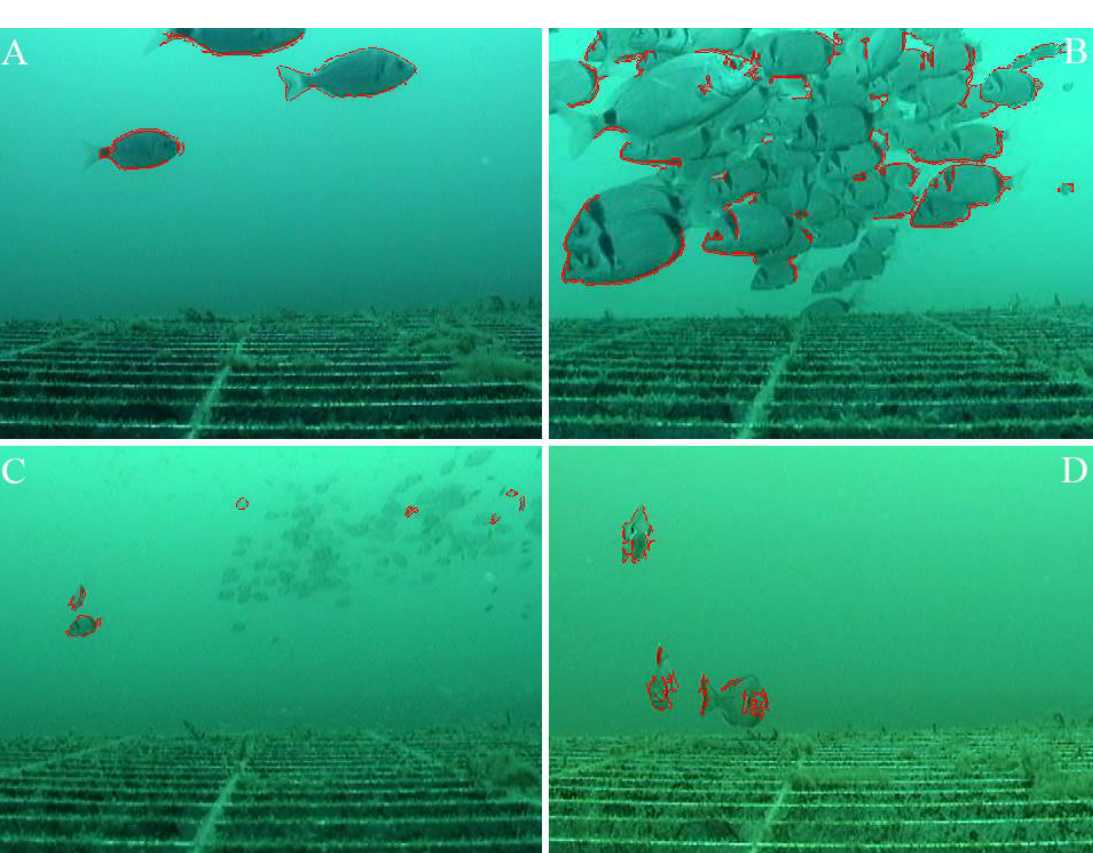
Figure 9. Examples of different types of errors (see Table 2 for references on their typologies) encountered during the automated processing of images taken by the OBSEA cabled seafloor observatory video camera: (A) is an example of an image with correctly classified fishes; (B) is an example of an image with a fish school (>20 animals) classified as containing less than 10 individuals (Img > 20-Class < 10 in Table 2); (C) is an example of an image in which a distant school is not fully differentiated from the background; and (D) is an example of an image where the resampling of the same object occurred ( i.e. , M > N in Table